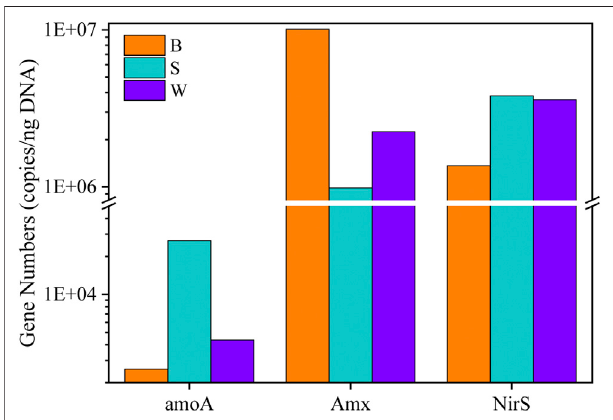
FIGURE 5 | Comparison of AOB, anammox, and DNB abundance by qPCR. amoA , ammonia monooxygenase gene; Amx , Anammox; nirS , nitrite reductase